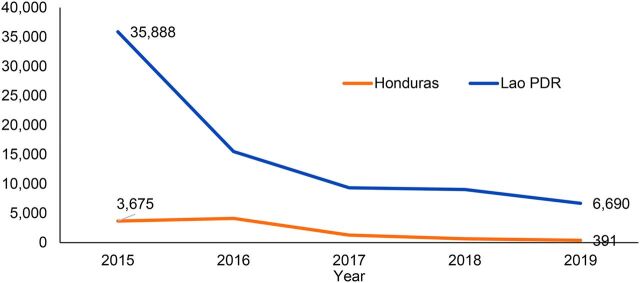
Reported National Malaria Cases in Honduras and Lao PDR, 2015–201911,18Abbreviation: PDR, People's Democratic Republic.